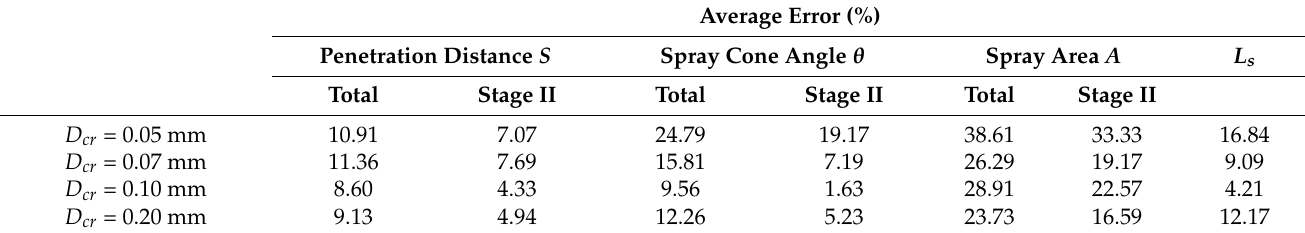
Table 2. Average error. Average Error (%) Penetration Distance S Spray Cone Angle θ Spray Area